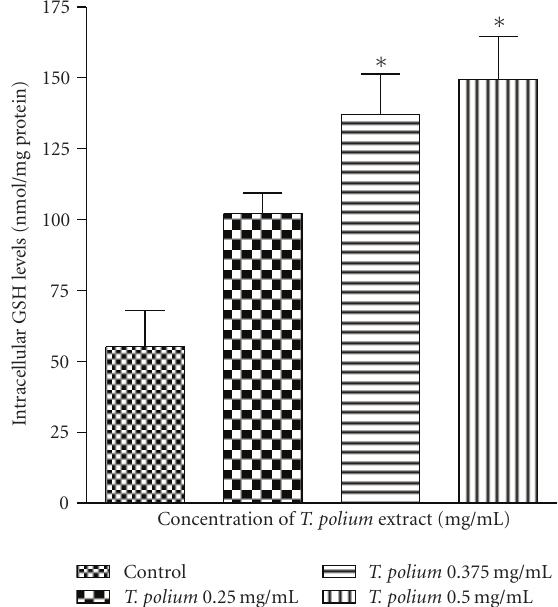
Figure 4: E ff ect of a 24-hour exposure of an aqueous extract of T. polium on reduced glutathione (GSH) levels in HepG2 cultured cells. Data are presented as mean ± standard deviation. Sample size ( n ) = 8. ∗ p < 0 . 01 represents the significance of the di ff erence from the control.